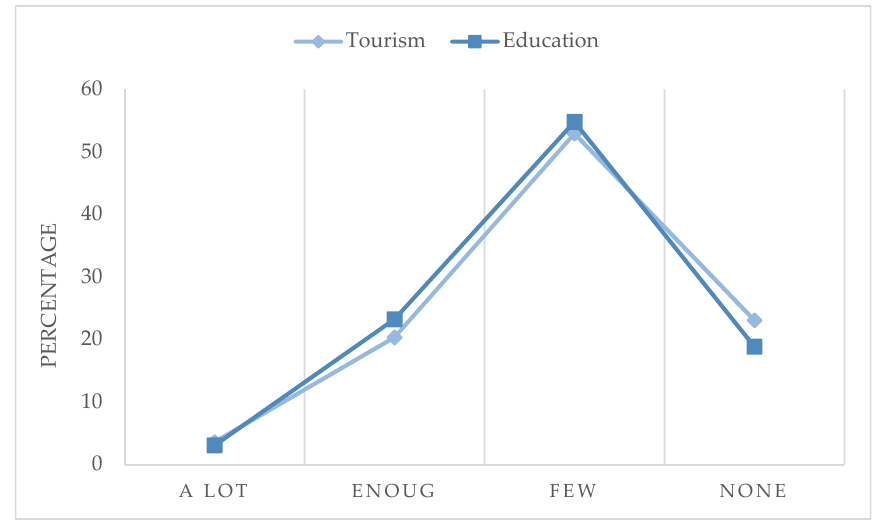
Figure 5. Training in heritage education for students in primary education or tourism. Table 12. Evaluation of criteria according to different